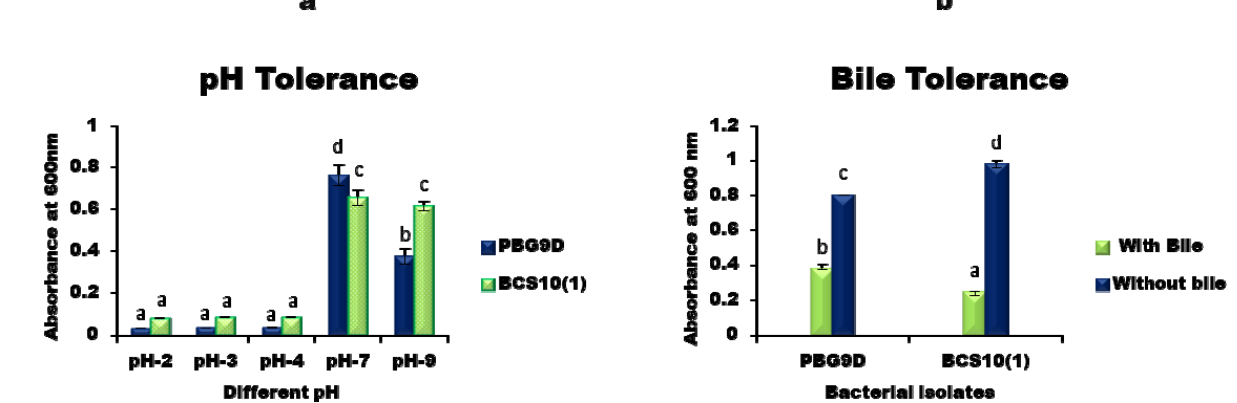
Figure 3. ( a ) Bacterial growth at different pH. ( b ) Bile tolerance potential of isolated bacterial strains. Values represent mean ± SD (n = 3). Different letters on bars indicate significant difference ( p ≤ 0.05) between groups (PBG9D and BCS10 (1)).